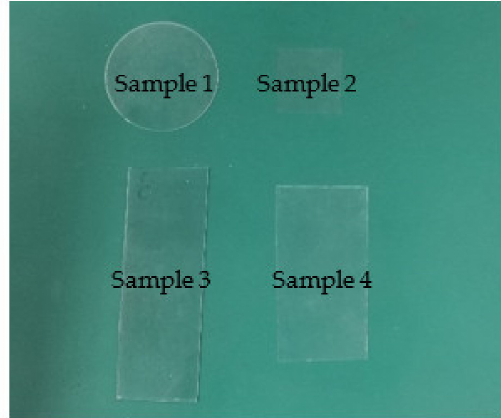
Figure 16. Picture of the transparent specimens.